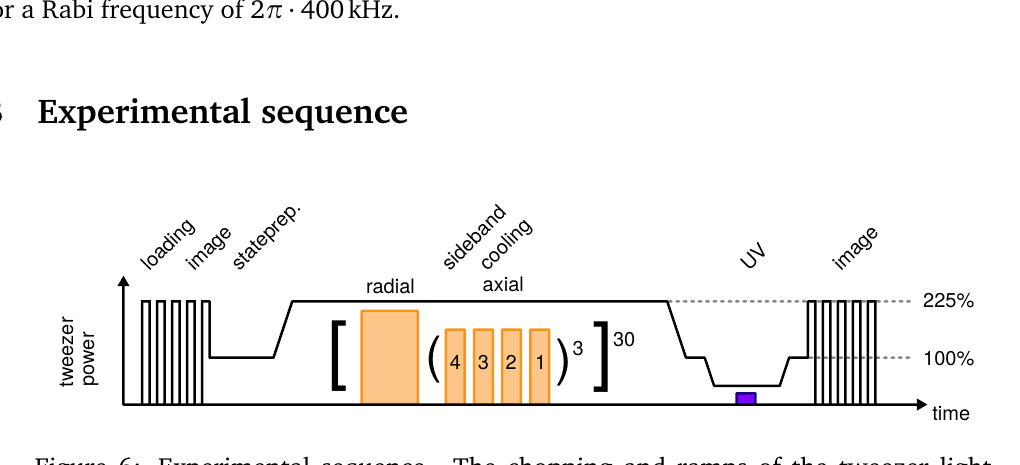
Figure 6: Experimental sequence. The chopping and ramps of the tweezer light (black lines), the Raman cooling light (yellow) and the UV pulse (purple) are shown. The numbers for the axial Raman sideband cooling indicate the n th sideband used for cooling, the brackets indicate the repetition of cooling